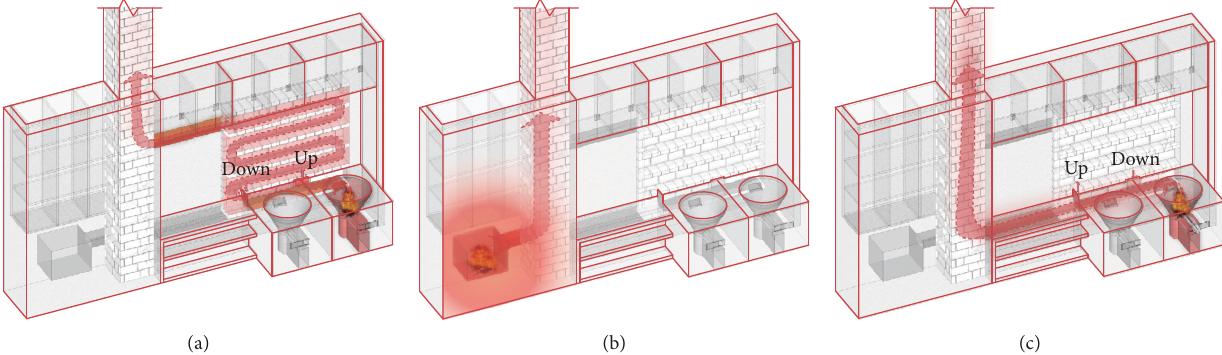
Figure 4: Operation modes for the heat recovery system, applied in different seasons. (a) Winter mode, heating with heated wall; (b) winter mode, heating with fireplace; and (c) winter mode, cooking without enabling the heated wall.